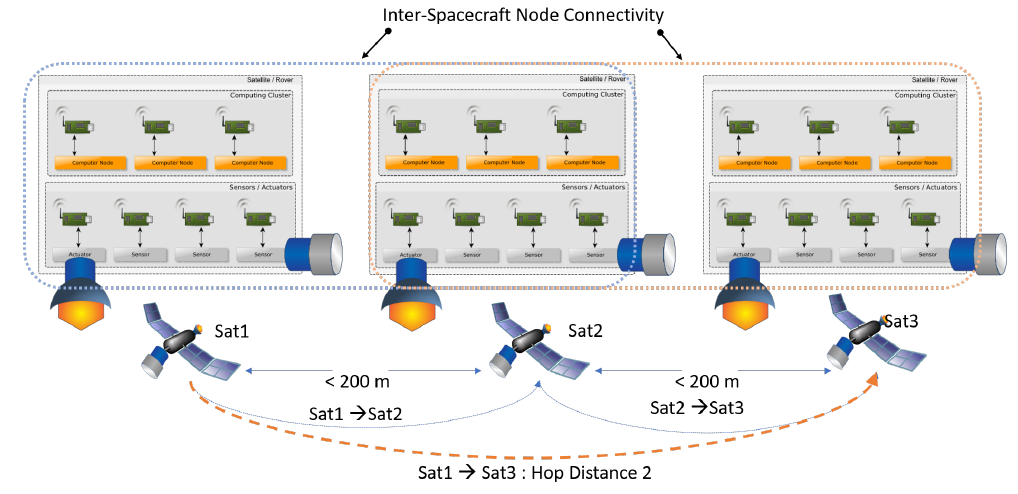
Figure 4. Multi hop data exchange between satellite nodes that are further